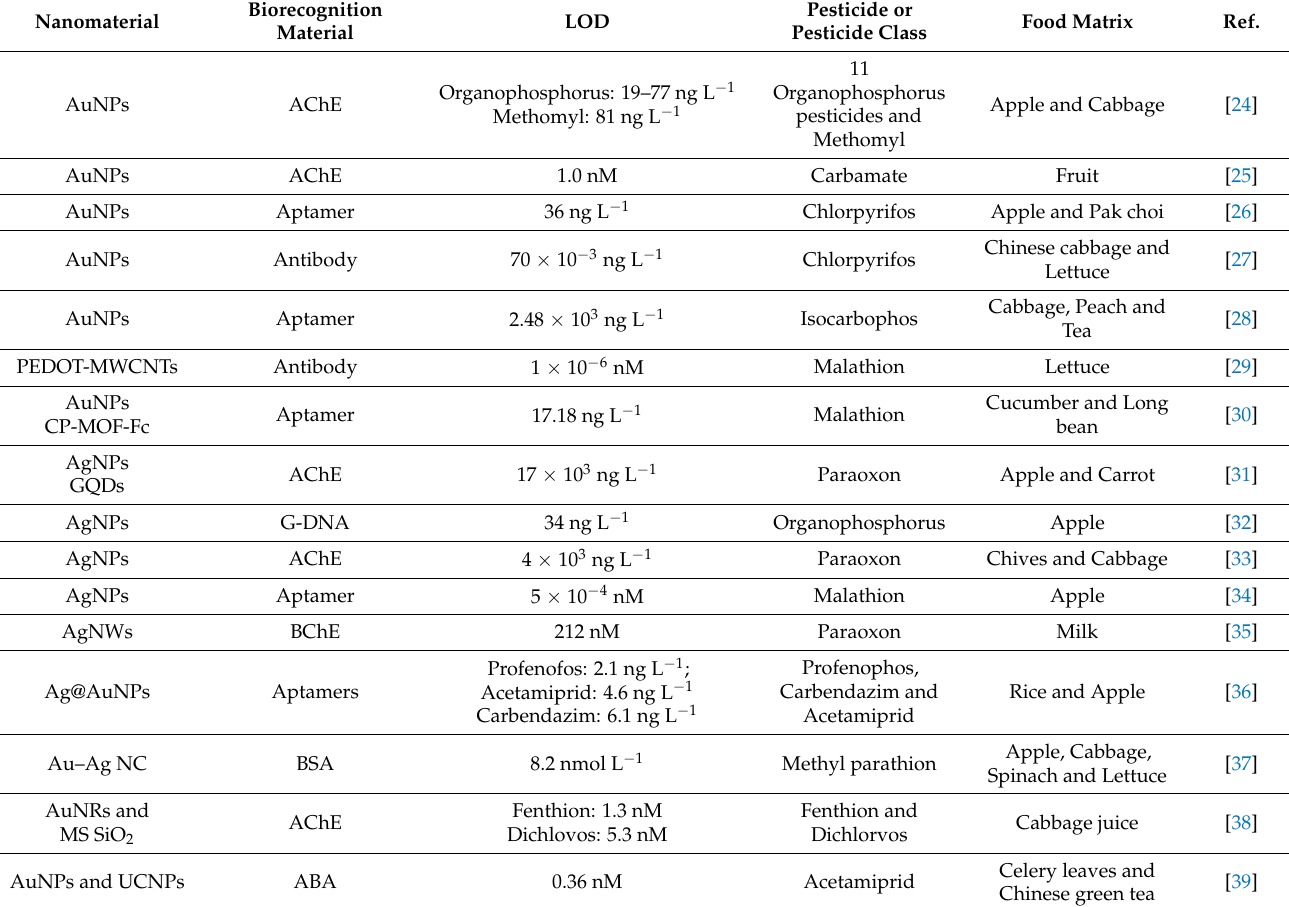
Table 2. Description of biosensors focusing on the type of nanomaterial used.